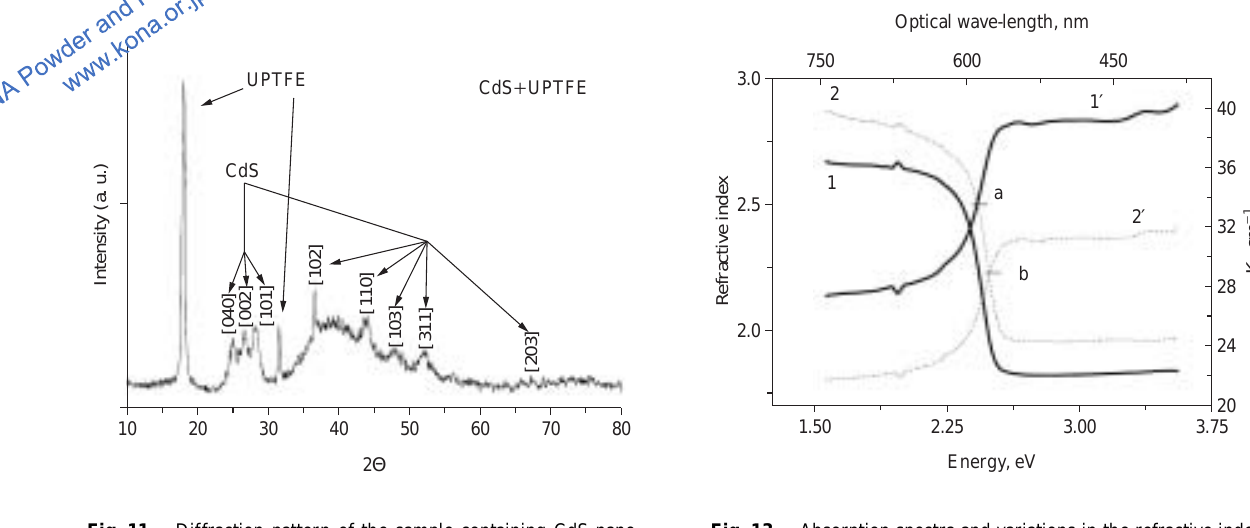
Fig. 13 Absorption spectra and variations in the refractive index of CdS-PTFE